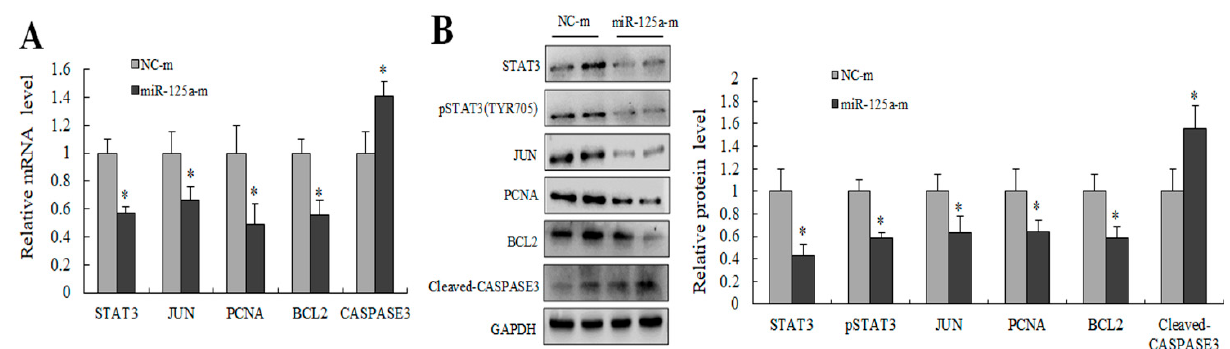
Figure 6. miR-125a inhibited hepatocytes proliferation by STAT3/P-STAT3/JUN/BCL2 axis. ( A ) STAT3, Figure 6. miR ‐ 125a inhibited hepatocytes proliferation by STAT3/P ‐ STAT3/JUN/BCL2 axis. ( A ) STAT3, JUN, BCL2, PCNA and CASPASE3 were detected by qRT ‐ PCR in BRL ‐ 3A cells after the JUN, BCL2, PCNA and CASPASE3 were detected by qRT-PCR in BRL-3A cells after the treatment of treatment of miR ‐ 125a reagents. ( B ) . STAT3, JUN, BCL2, PCNA and Cleaved ‐ CASPASE3 were miR-125a reagents. ( B ). STAT3, JUN, BCL2, PCNA and Cleaved-CASPASE3 were detected by WB detected by WB in BRL ‐ 3A cells after treatment of miR ‐ 125a reagents, the samples derive from the same experiment and that gels/blots were processed in parallel. Data are shown as mean ± SEM, * p < 0.05.